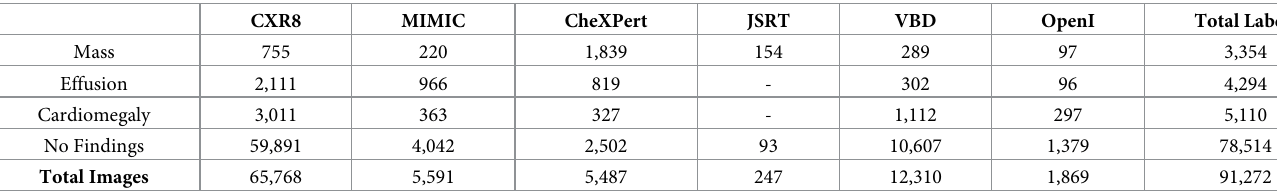
Table 2. Distribution of labels of included datasets.